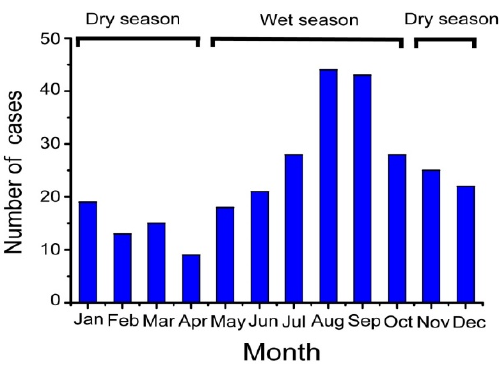
Figure 4. Monthly distribution of 289 melioidosis cases across 13 years (2002–2014) in Hainan, China. Table 1. Summary of clinical presentation of 277 melioidosis cases from Hainan.